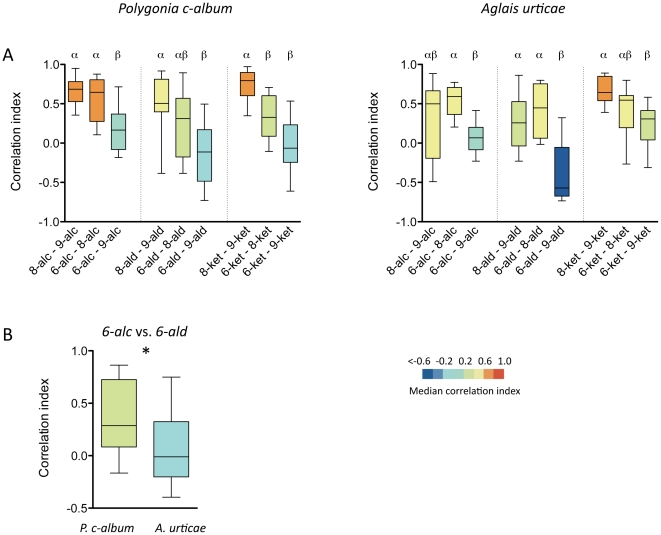
Correlation between chemical structure and response.
A Pairwise correlations between compounds with the same functional group but different chain length. In each group (alcohols, aldehydes or ketones) in a graph the chain length of the compounds differ by 1, 2 or 3 carbon atoms, respectively. Bars capped by different letters differ significantly within the chemical group (Kruskal Wallis test followed by Dunn's Multiple Comparison Test). A box plot shows the median correlation index of a pair of odorants (horizontal line), the 25th and 75th percentile (lower and upper margin of the box) together with the minimum and maximum values (whiskers). The colour coding depicts the median correlation index according to the scale. A. urticae (n = 10) and P. c-album (n = 15). B Correlation of responses to two compounds (6-alc and 6-ald) with the same chain length but different functional group (* p<0.05; Mann-Whitney-U test).